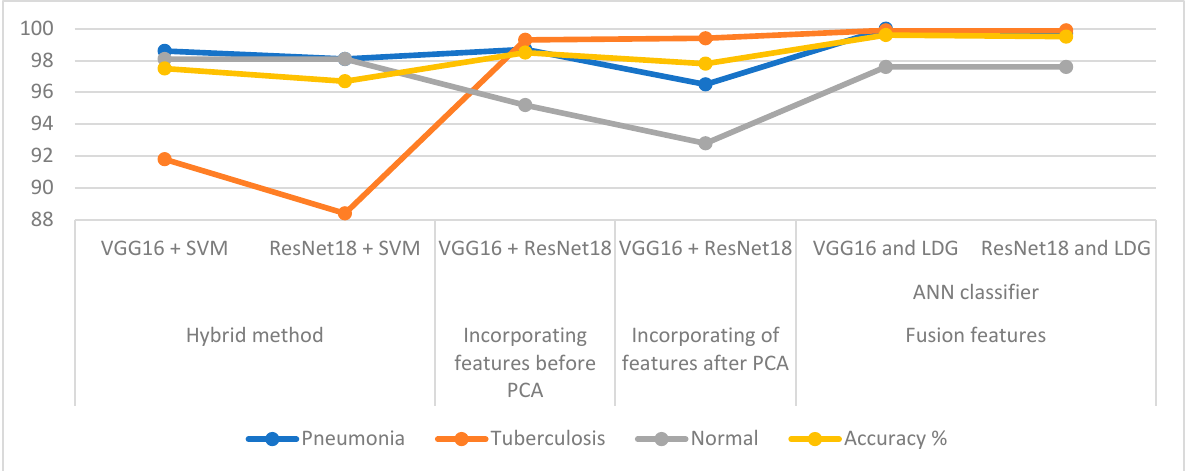
Figure 16. The execution and differentiation of the proposed methods for diagnosing the X ‐ rays of the pneumonia and tuberculosis data set.